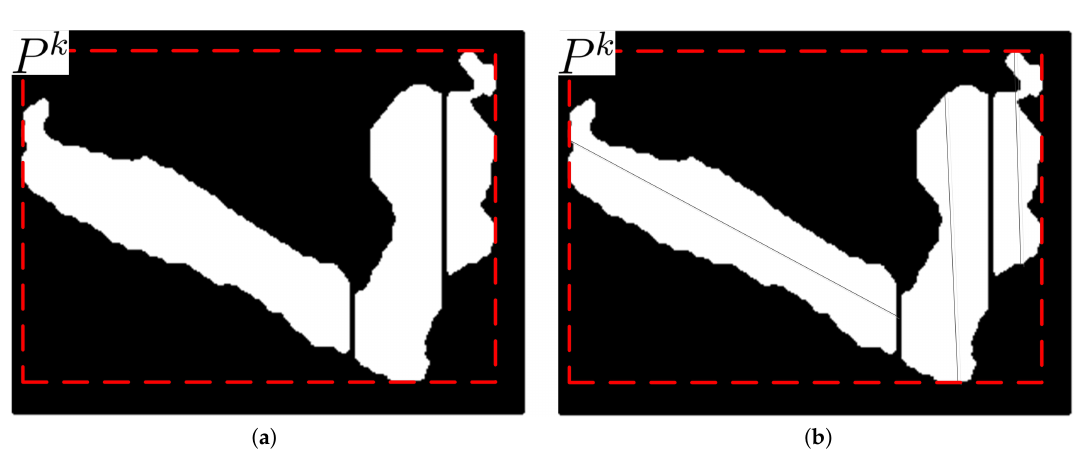
Figure 9. Calculation of the major axis of each partitioned object after vertical histogram analysis: ( a ) Partitioned objects; ( b ) Major axes of the virtual matched